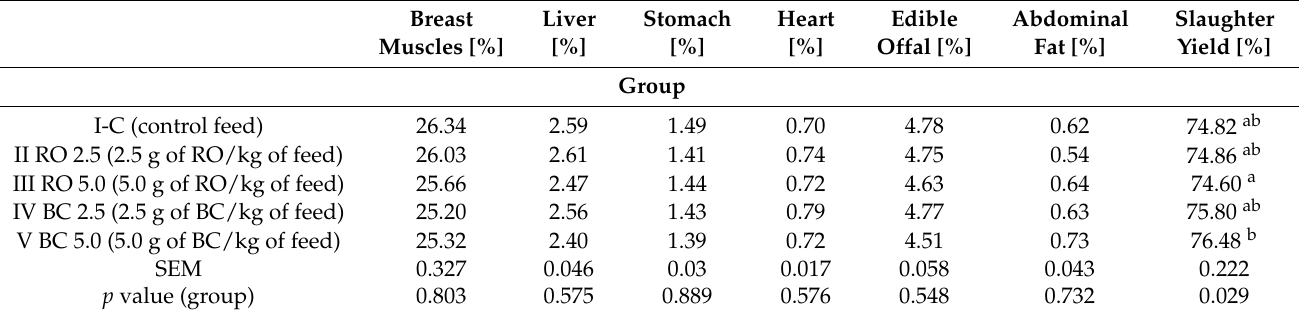
Table 4. Effects of dietary treatments on slaughter yields and proportions of selected carcass organs.